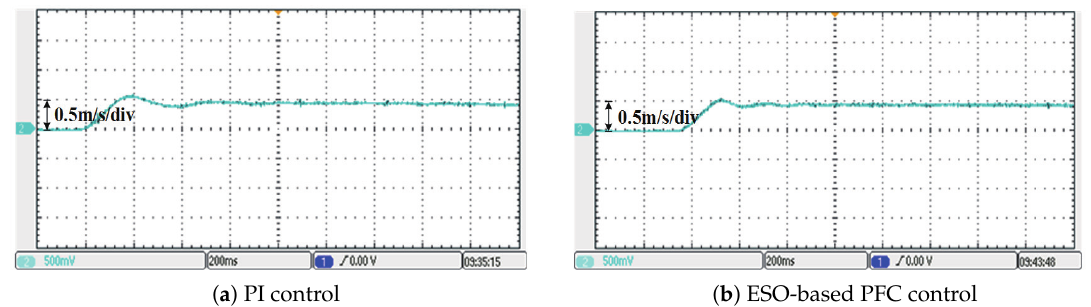
Figure 6. Speed response curves (no load).